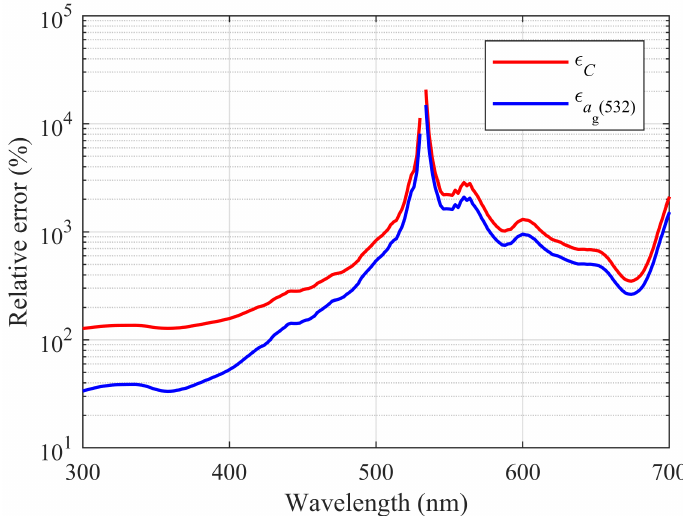
Figure 4. The e ff ect of λ 2 on retrieval error when λ 1 is fixed at 532